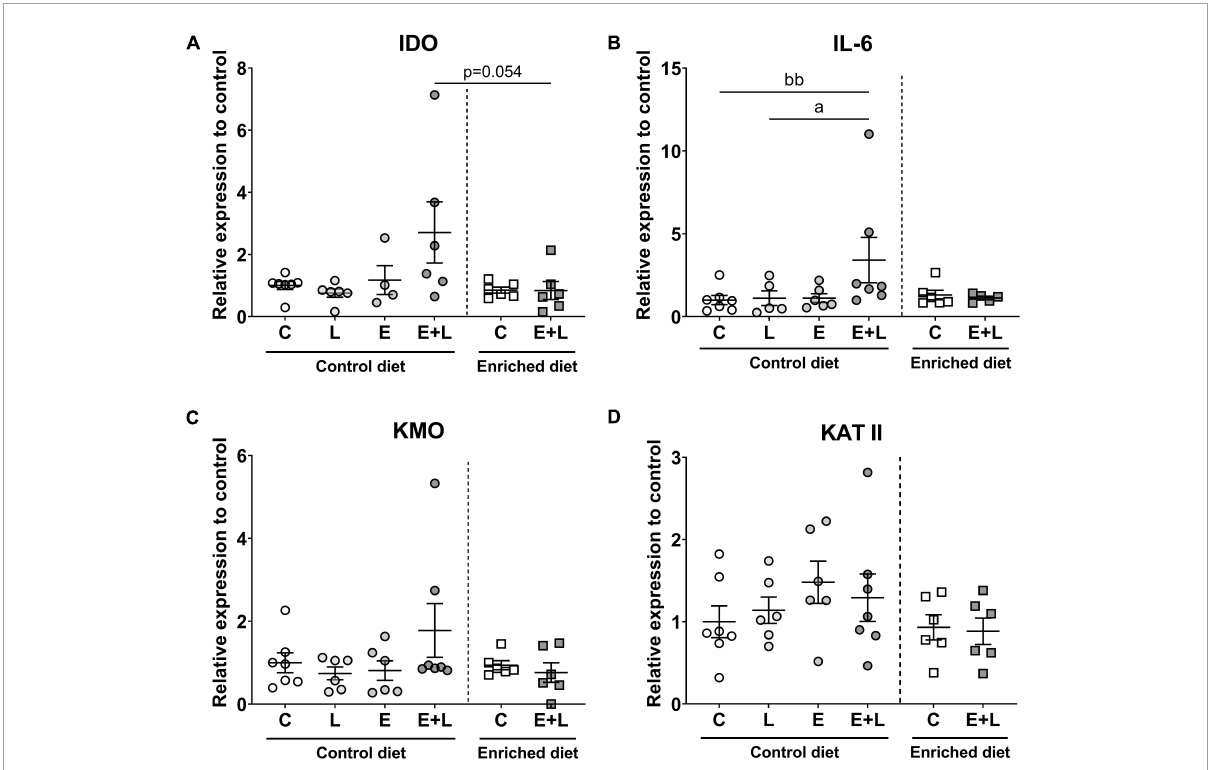
FIGURE11 mRNA expression levels of kynurenine pathway markers in the PFC of the brain. These markers included IDO (A) , KMO (B) , IL-6 (C) , and KATII (D) . Relative expression levels to control are presented. Data are expressed as mean ± SEM. a p < 0.05 (first analysis for elastase and/or LPS effects). bb p < 0.01 (second analysis for diet and/or E + L effects). C, control; L, LPS; E, elastase; E + L, elastase plus